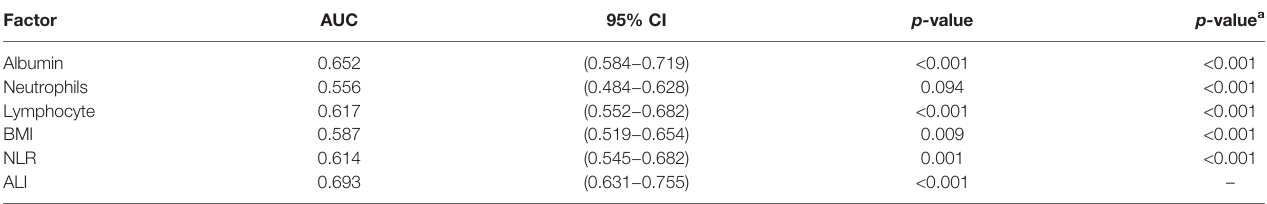
ALI, advanced lung cancer in fl ammation index; AUC, area under the curve; BMI, body mass index; NLR, neutrophil-to-lymphocyte ratio. a The AUC values between the advanced lung cancer in fl ammation index and other factors were compared using the Z-test method. The Mann – Whitney U test ( ※ Z-test: albumin: − 6.416; neutrophils: − 8.739; lymphocyte: − 8.837; BMI: − 6.203; NLR: − 13.758).